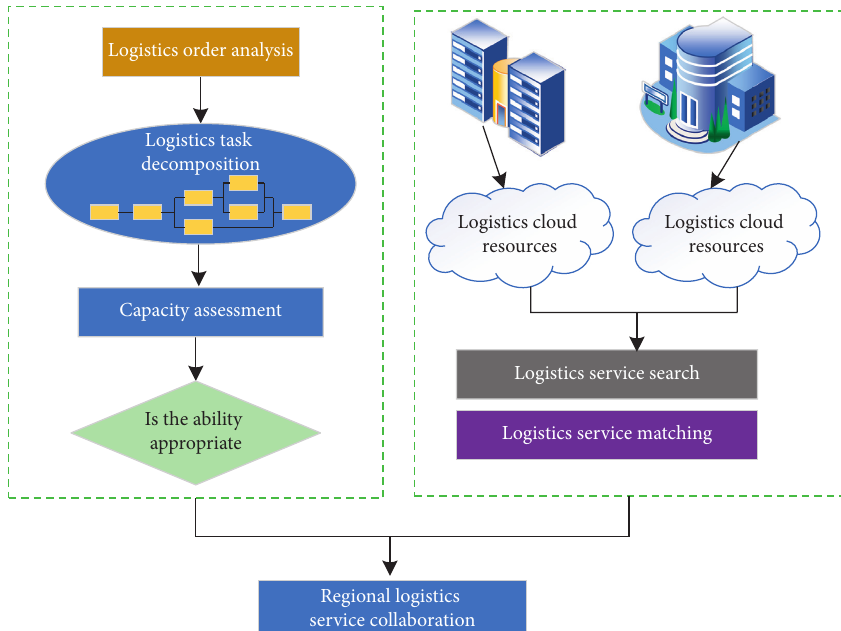
Figure 3: Service process of regional logistics cloud.